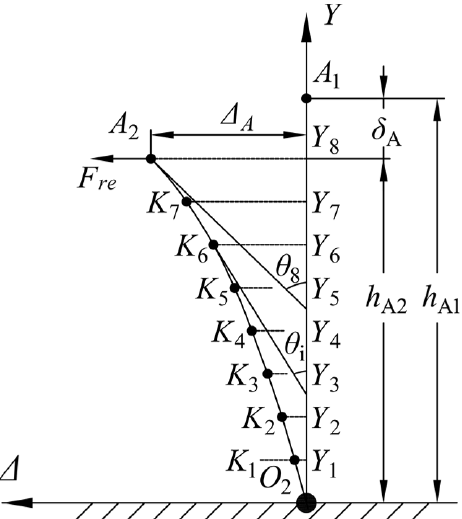
Figure 3. Rice plant partition and calculation. F re is the resultant force of F h , W h and F M , N; h A 1 and h A 2 are the heights of point A before and after deformation, mm; δ A and Δ A are the vertical and horizontal displacement of point A 2 , mm; θ 8 is the angle between the tangent line of point A 2 and the axis Y , (°); θ i represents the angle between the tangent line of point K i and the axis Y , (°).